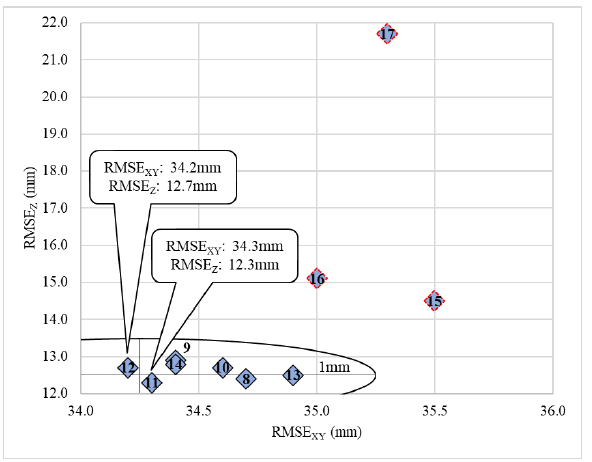
Figure 10 . Results from second round of testing.